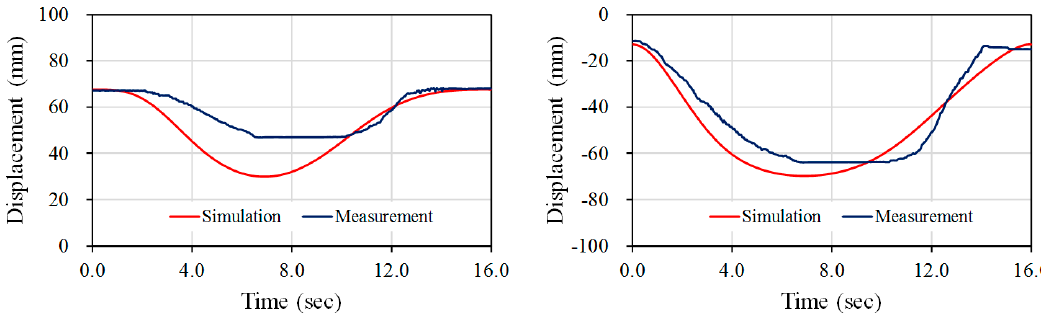
Figure 5. Simulated and measured displacements for x -direction ( left ) and y-direction ( right ).